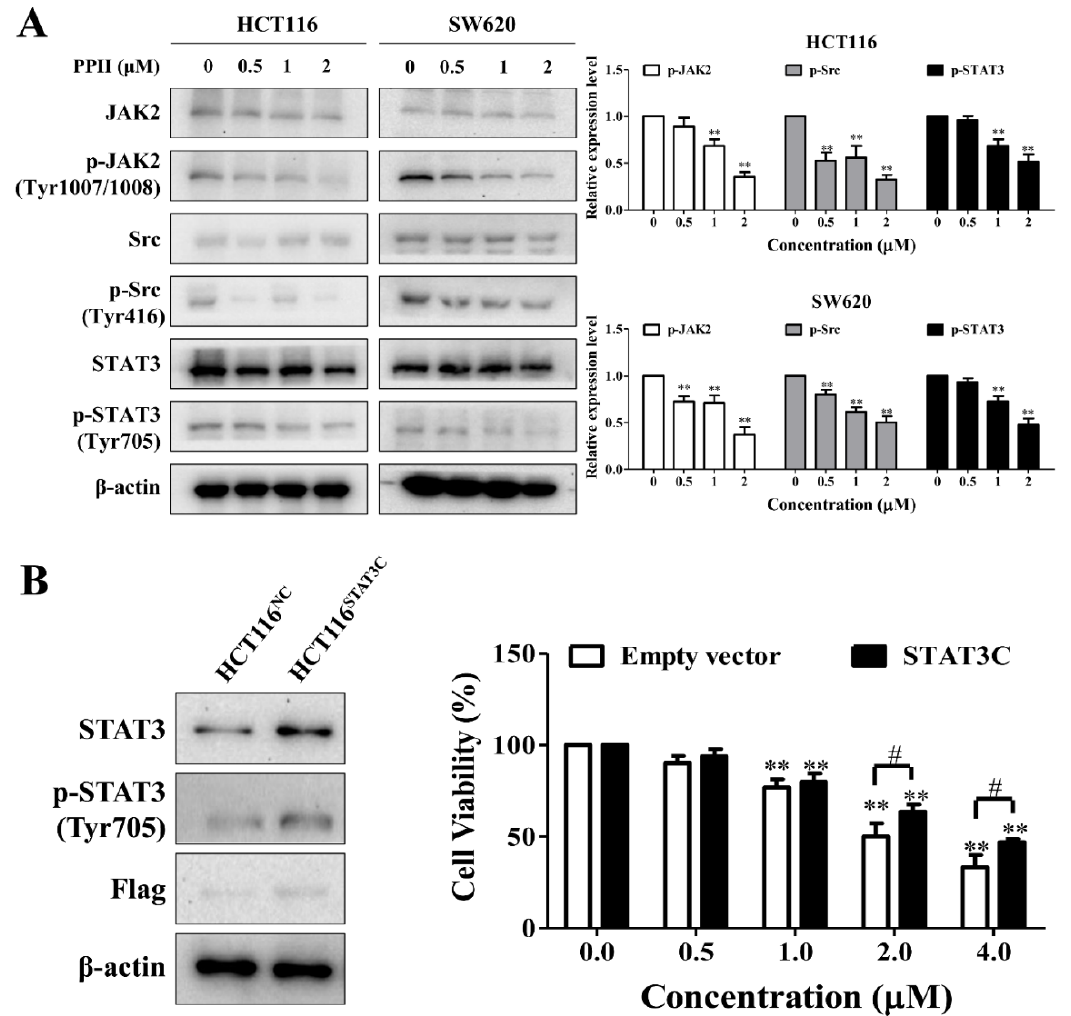
Figure 6. The inhibition of STAT3 signaling is associated with PPII-induced CRC cell death. ( A ) The phosphorylation and total levels of STAT3, JAK2, and Src in CRC cells were examined using Western blotting after exposure to PPII for 24 h. ( B ) The overexpression of constitutively active STAT3 (STAT3C) mitigated the cytotoxicity of PPII against the HCT116 cells. The protein levels and cell viability were determined using Western blotting and MTT assays, respectively. The representative immunoblotting bands are presented in the left panels, and the quantitative results are shown in the right panels. The data in bar the charts are the means ± SD of three independent experiments. ** p < 0.01 vs. vehicle control. # p < 0.05.